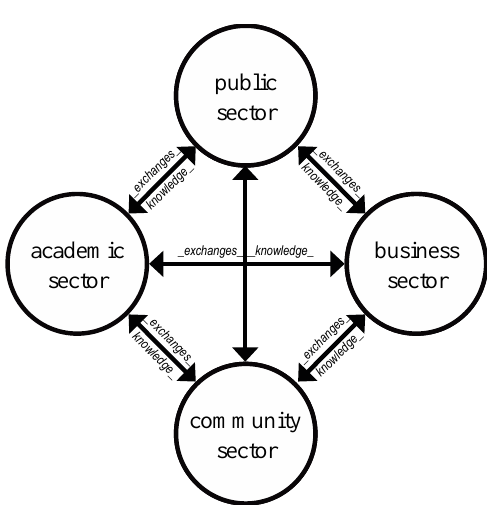
Figure 4. “Quadruple helix” stakeholder model adapted from Arnkil et al . [25].